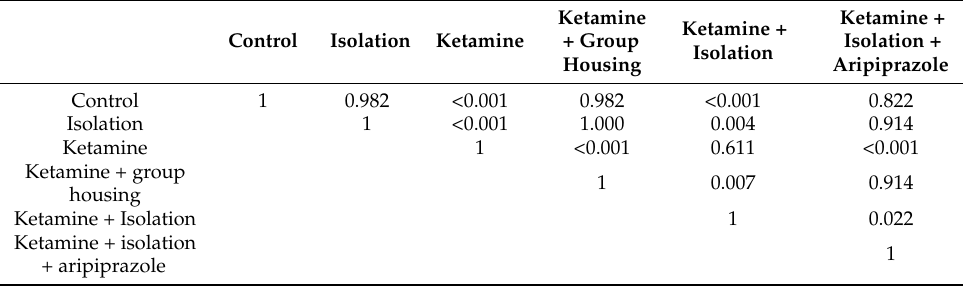
Figure 4. The effects of social isolation, ketamine, social isolation + ketamine, and social isolation + ketamine + aripiprazole on the spontaneous alternation percentage in the Y-maze test. The values are mean ± SD ( n = 7 for each group); 1 vs. 3a ( p = 0.00005), 1 vs. 4a ( p = 0.0094). * Significantly different when compared to control group ( p < 0.05). Table 5. All p -values for the percentage of spontaneous alternation in the Y-maze